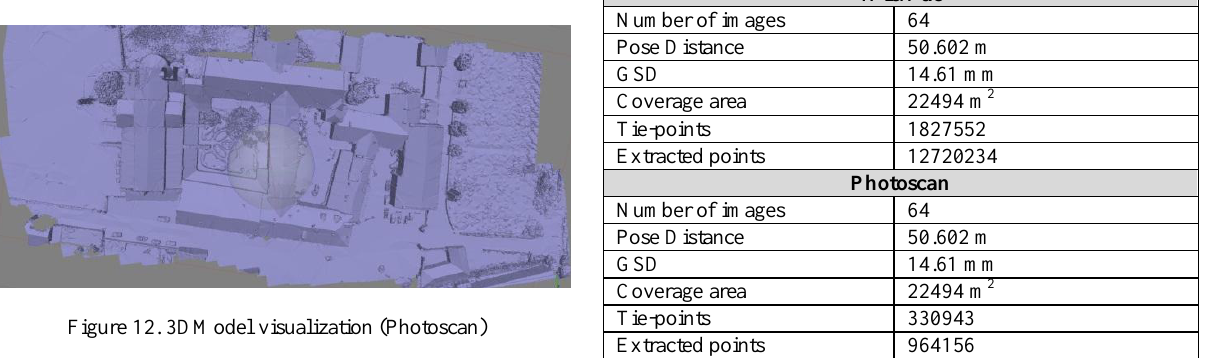
Figure 11. Visualization of calculated Tie Points with camera location in MicMac